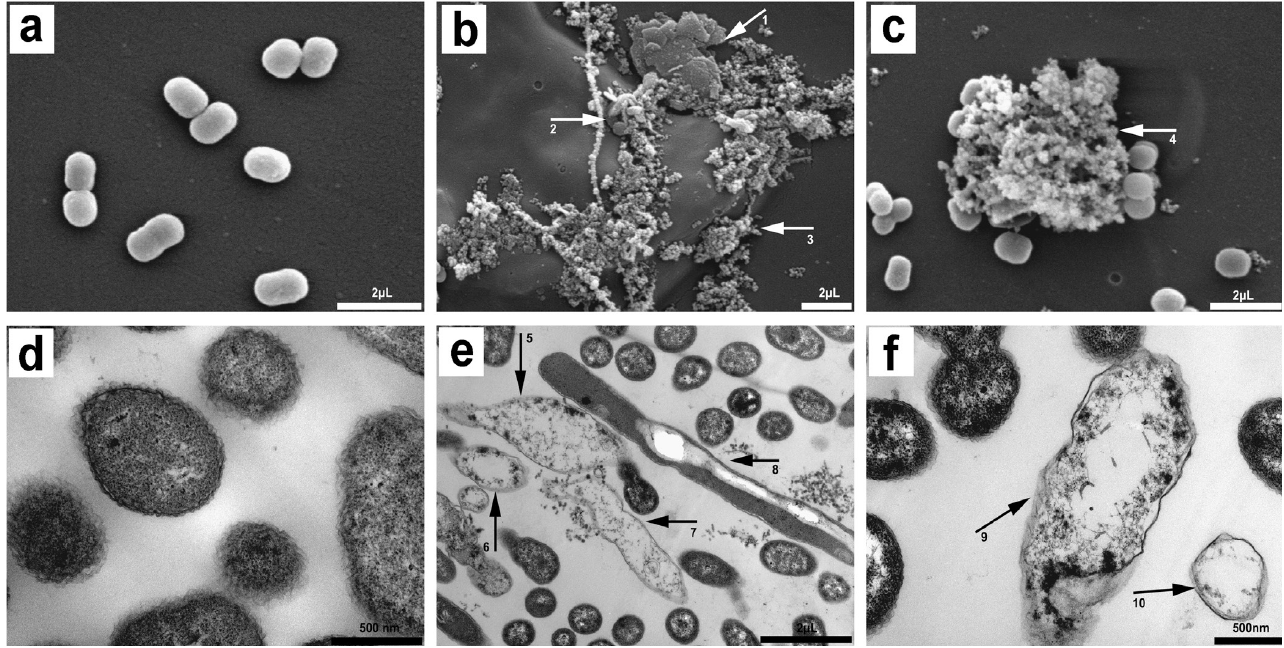
Fig. 2: Scanning electron microscope (SEM) and transmission electron microscope (TEM) photographs of Clavibacter michiganensis subsp . sepedonicus (Cms). Control (a 10000× and d 80000×), Cms cells treated with 0.80% DMSO. Treatment (b 6000×, c 8600×, e 20000×, and f 60000×), Cms cells treated with bioassay-guided fraction from A. sinense (PA) at the concentration of 0.20 mg/mL. Cms cells were adhered together (1 and 2), were seriously collapsed (3 and 4), showed anomalous shapes (5, 7, 8 and 9), and exhibited large vacuoles (5, 6, 7, 9 and